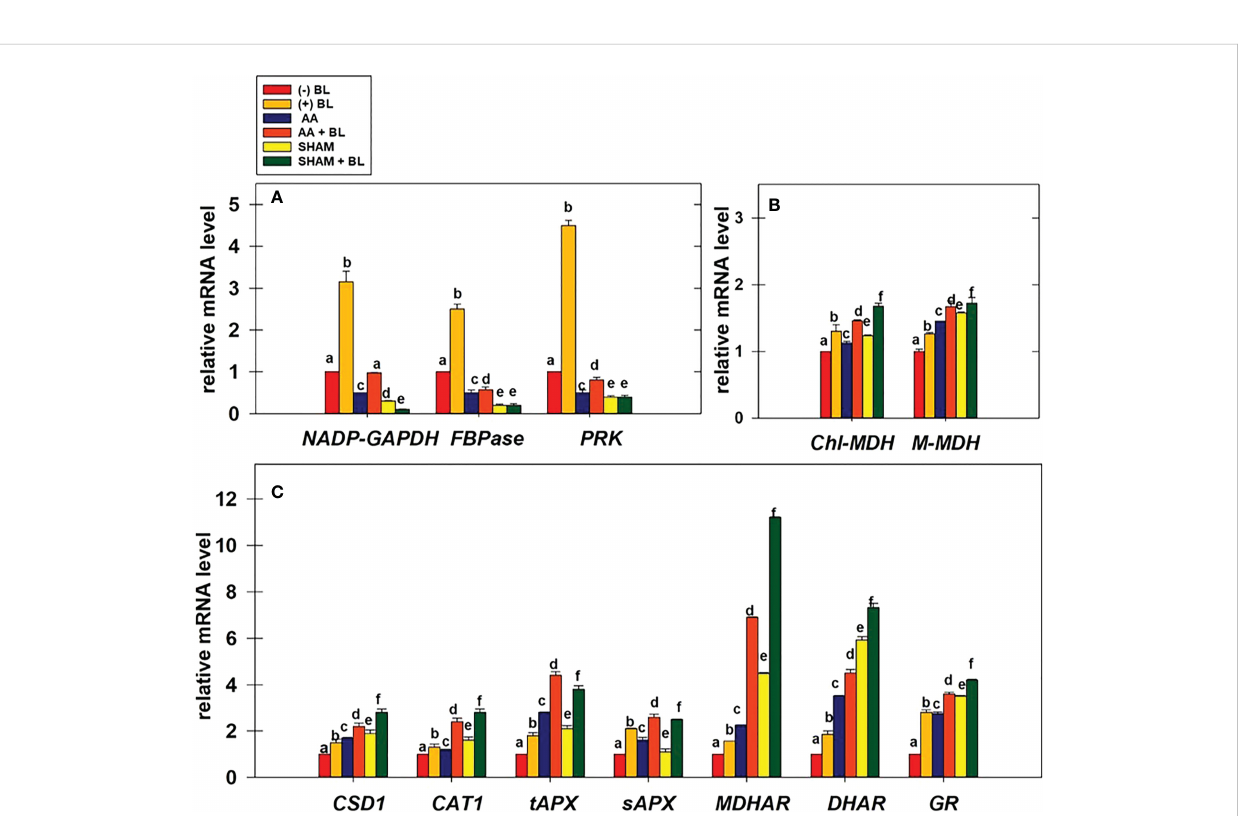
FIGURE 8 Effect of BL on gene expression pro fi les of enzymes related to CBC: NADP-GAPDH , FBPase , and PRK (A) ; malate valve: Chl-MDH , M-MDH (B) ; antioxidant system: CSD1 , CAT1, tAPX , sAPX , MDHAR , DHAR , and GR (C) under the disruption of COX pathway or AOX pathway. Total mRNA was isolated after treatment of leaf discs with or without BL (0.1 m M) in the presence or absence of AA (20 m M) or SHAM (0.5 mM) for 6 hours at a light intensity of 50 µmol m -2 s -1 at 25 °C. The amount of transcript was quanti fi ed by DD C T using UBQ5 as a positive control. Further, the section “ materials and methods ” mentions more detailed information on the procedure. No Inhibitor (No Inh) depicts a sample without mETC inhibitors. A statistically signi fi cant difference is represented by different lowercase alphabetical letters (P ≤ 0.05) and values represent the average (± SE) of three experiments.